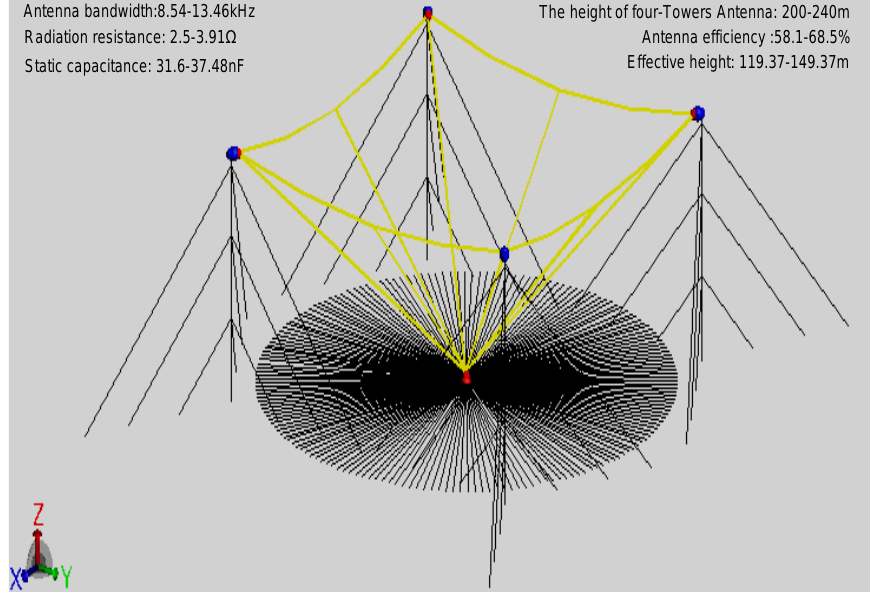
Figure 6. Schematic diagram of the four-tower inverted-cone antenna model. Table 2. Main Performance Parameters Of The four-tower Antenna. The height of four-Towers Antenna (m) 240 Tower spacing (m)